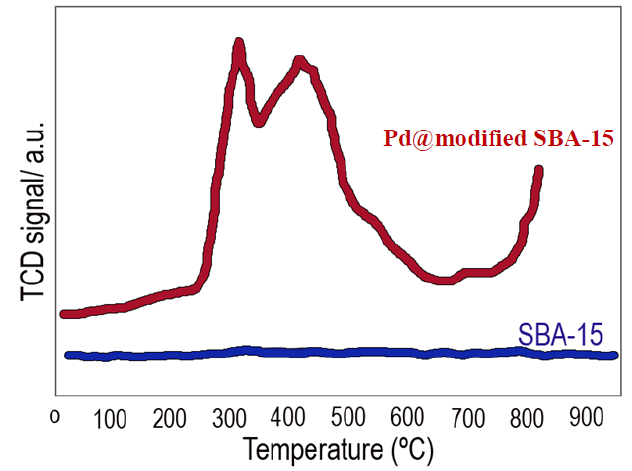
Fig. 9. NH -TPD spectra of SBA-15 and Pd@modified 3